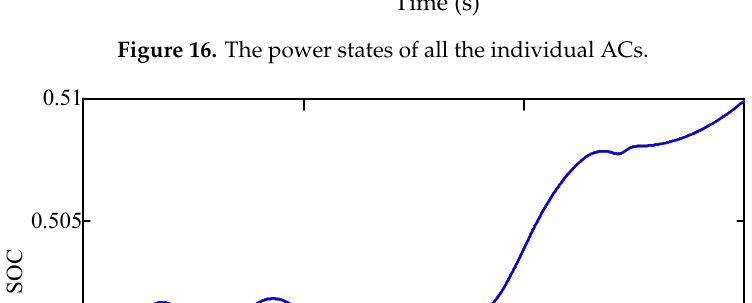
Figure 17. The energy states of all the individual ACs.